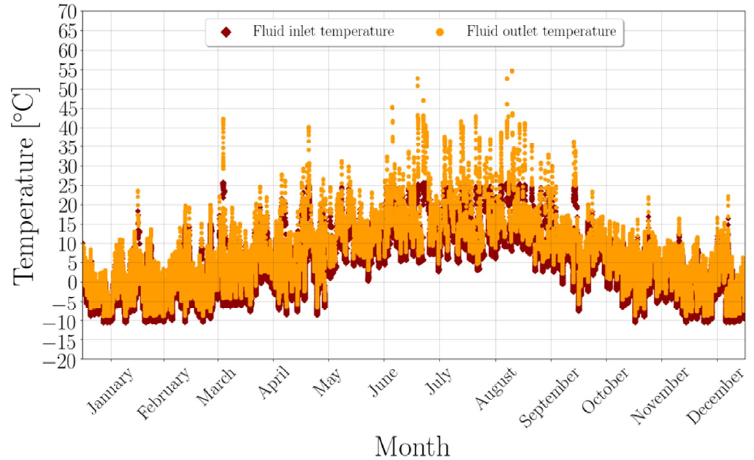
Figure 21. Hourly profile of the PVT fluid inlet and outlet temperature.